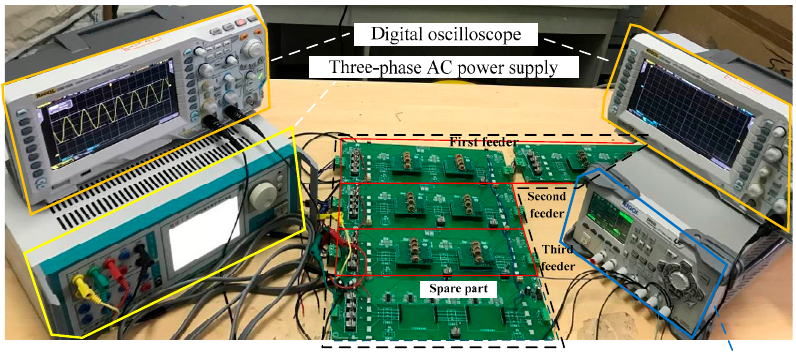
Figure 13. Experimental platform set-up for fault location in distribution systems.